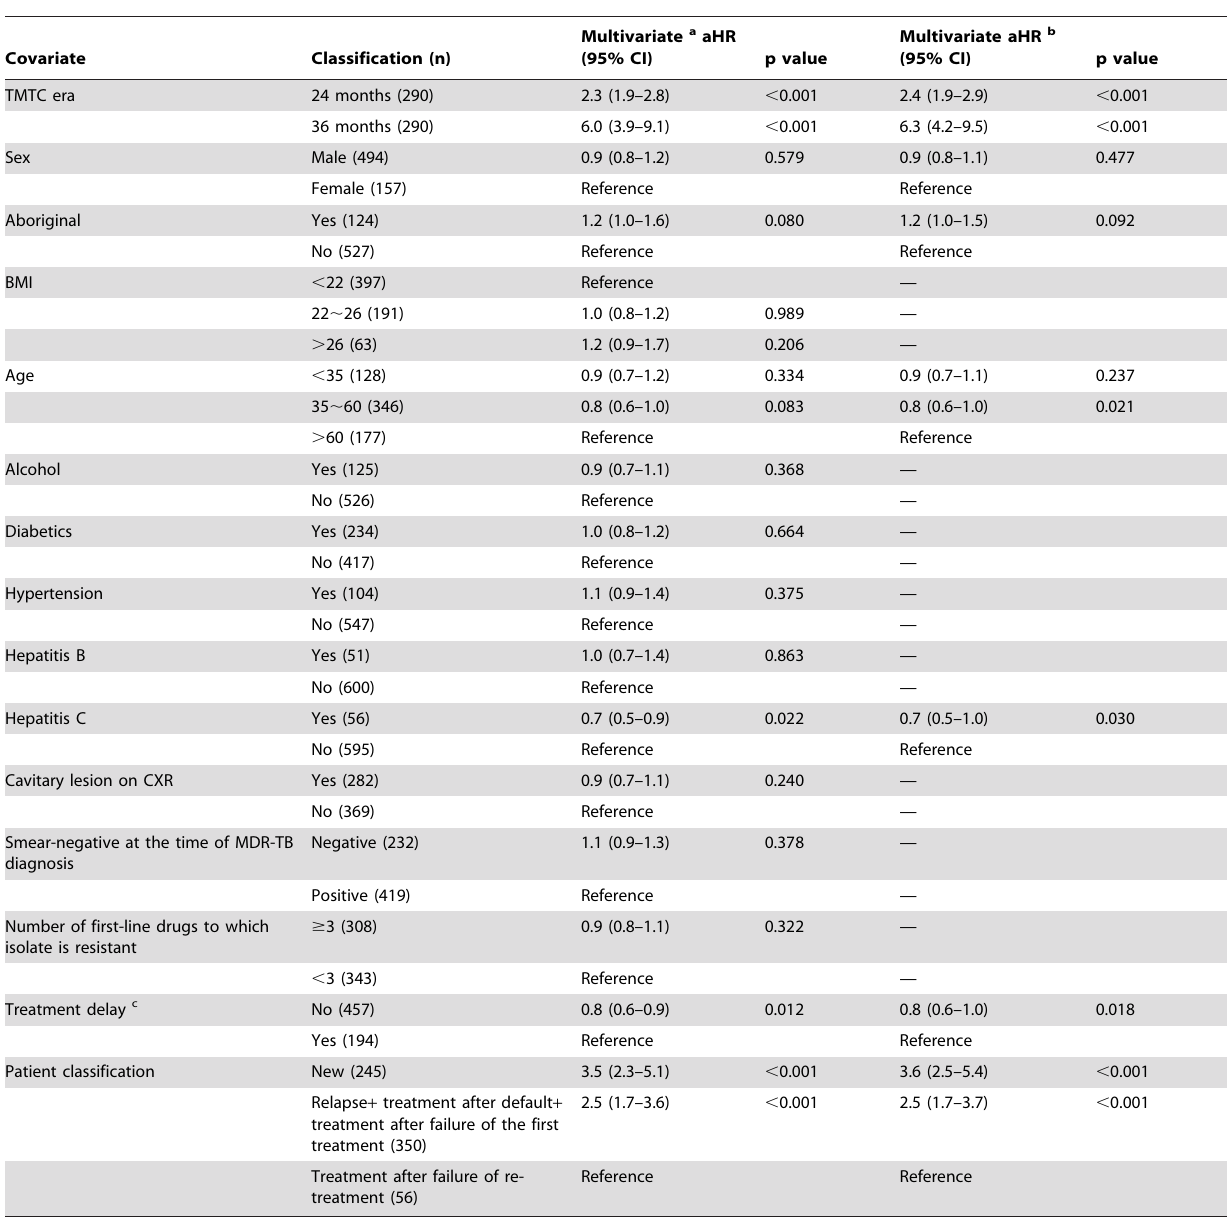
Table 4 . Prognostic factors associated with treatment success in a time-dependent Cox regression